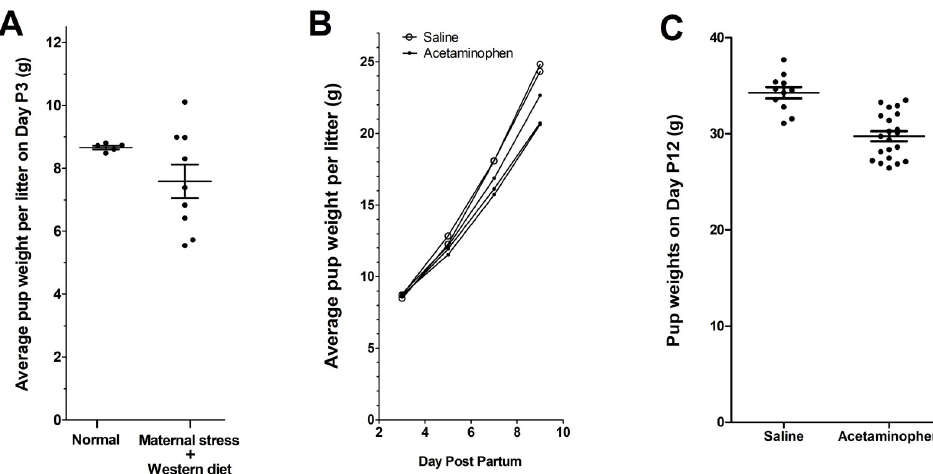
Fig 3. Weight of pups during the course of the experiment. In Panel A , the average weight of pups per litter on Day P3, prior to administration of acetaminophen or saline, is shown. The average weights of pups in litters born to mothers with a Western diet and experimentally induced psychological stress were much more widely distributed (21.1% coefficient of variation) than were average weights of pups in litters born to animals without a Western diet and psychological stress (“Normal”; 1.5% coefficient of variation; F test: p = 0.0002). In Panel B , changes over time in the average pup weight per litter in animals without a Western diet and experimentally induced psychological stress are shown. Panel C shows the weights of individual pups born to animals without a Western diet or experimentally induced psychological stress as a function of acetaminophen exposure versus saline as a control. Pups exposed to acetaminophen weighed on average 13.2% less than pups receiving saline (t test: p < 0.0001), despite having essentially the same average weights on day 3 prior to initiation of drug exposure (Panel B).